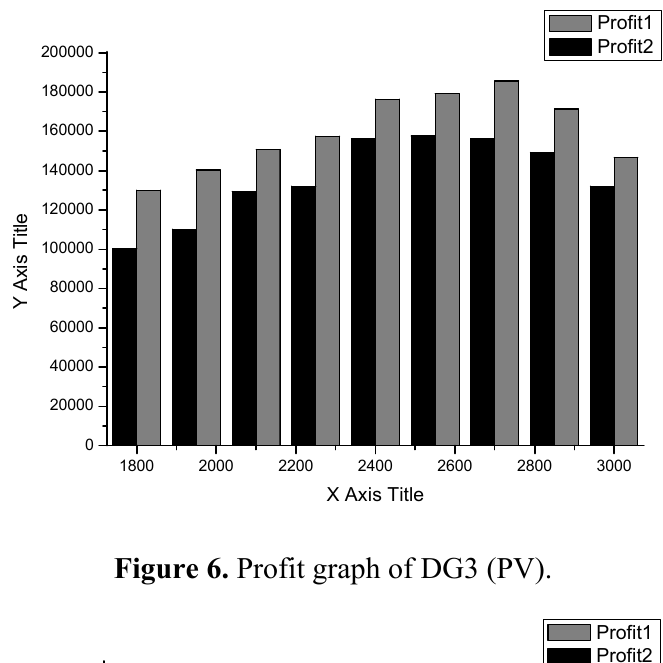
Figure 5. Profit graph of DG2 (Wind).